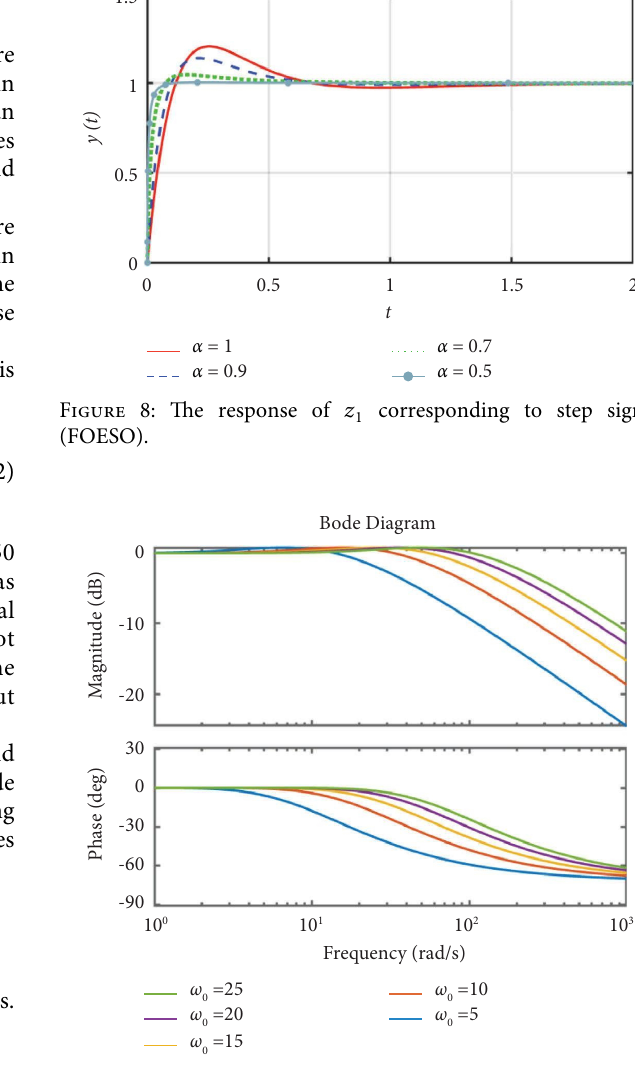
Figure 7: Te response of z (ESO).